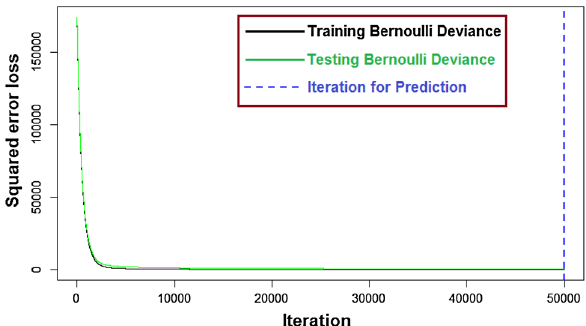
Fig. 6 Optimal number of iterations in the GBM algorithm indicated by the vertical blue dashed line , while the black and green lines refer to the training and testing Bernoulli